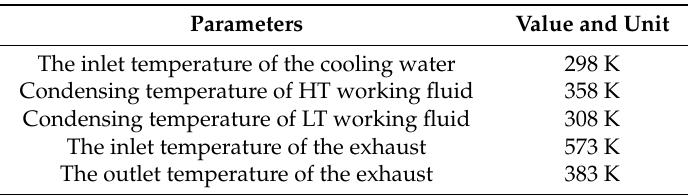
Table 3. Main parameters used in the